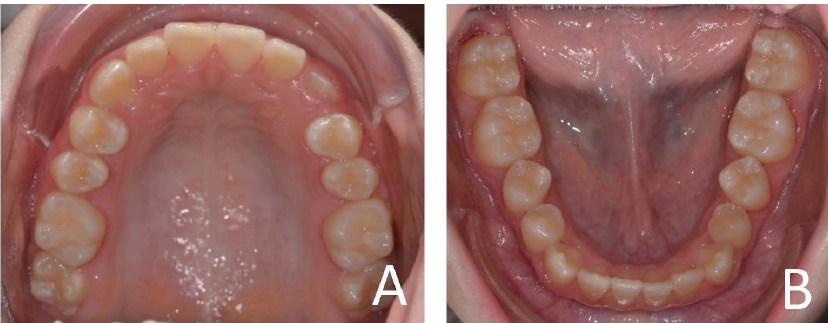
Figure 35. Occlusal photos of dental arches after treatment and a 3-year follow-up period (12-year-old). ( A ) Upper arch; ( B ) lower arch.